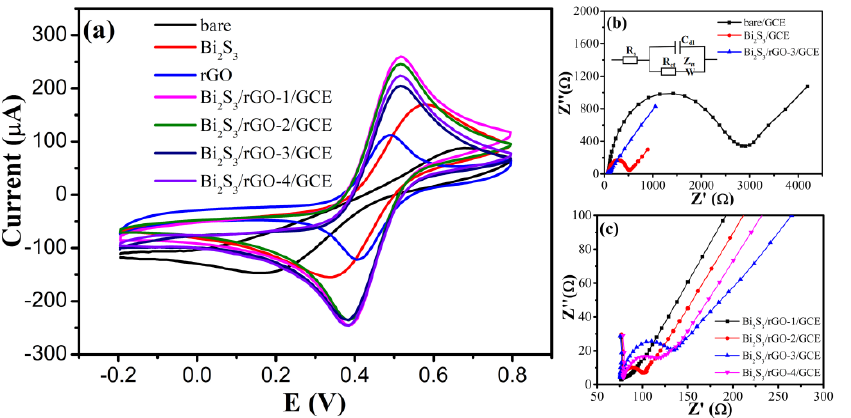
Figure 5. ( a ) CVs of bare GCE, Bi 2 S 3 /GCE, GO/GCE, Bi 2 S 3 /rGO-1/GCE, Bi 2 S 3 /rGO-2/GCE, Bi 2 S 3 /rGO-3/GCE, and Bi 2 S 3 /rGO-4/GCE in 0.1 M KCl containing 5 mM [Fe (CN) 6 ] 3−/4− ; ( b ) EIS of bare GCE, Bi 2 S 3 /GCE, and Bi 2 S 3 /rGO-1/GCE; ( c ) EIS of Bi 2 S 3 /rGO-1/GCE, Bi 2 S 3 /rGO-2/GCE, Bi 2 S 3 /rGO-3/GCE, and Bi 2 S 3 /rGO-4/GCE. The inset in ( b ) represents the equivalent circuit model.